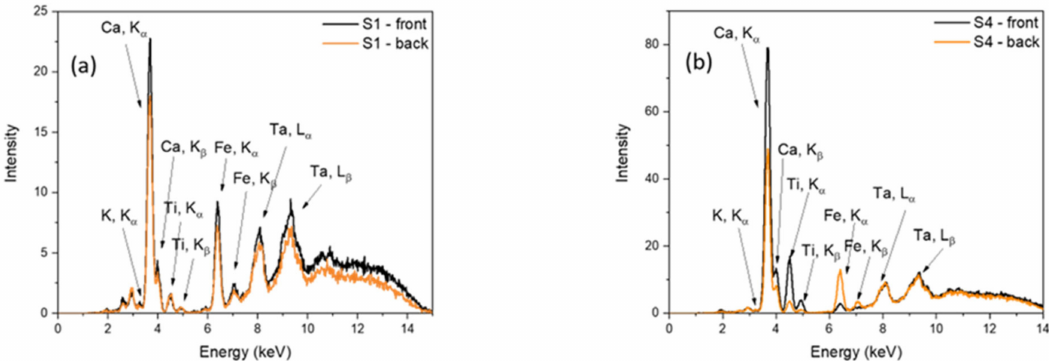
Figure 2. Representative XRF spectra, in the 0–14 keV range, collected on the front and back sides of samples S1 ( a ) and S4 ( b